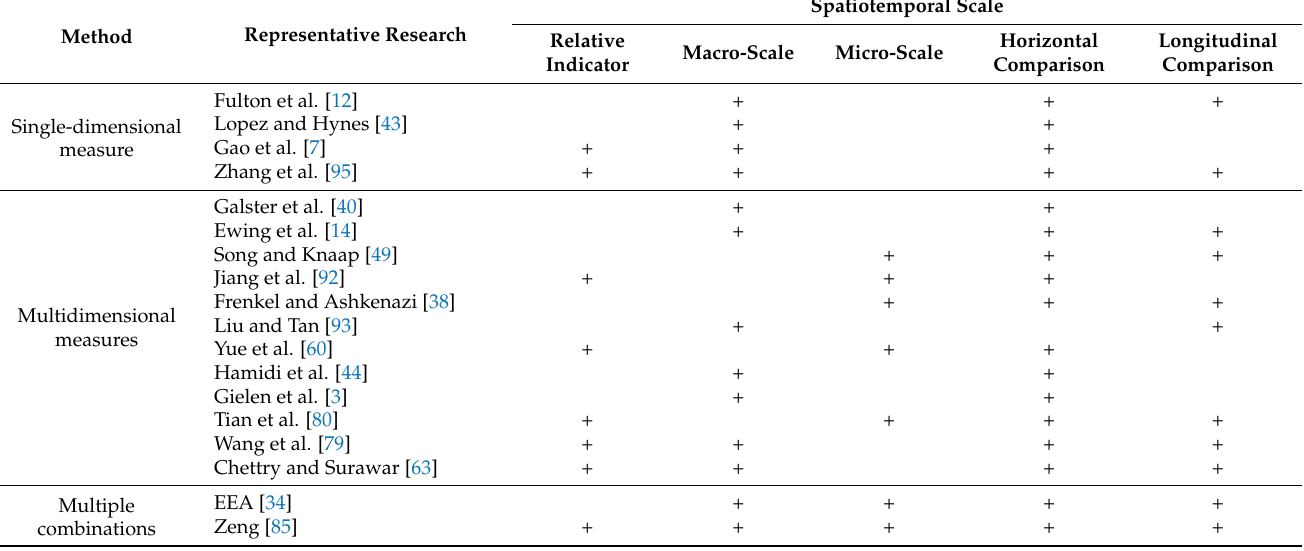
Table 1. Combinations of spatial and temporal scales for measuring